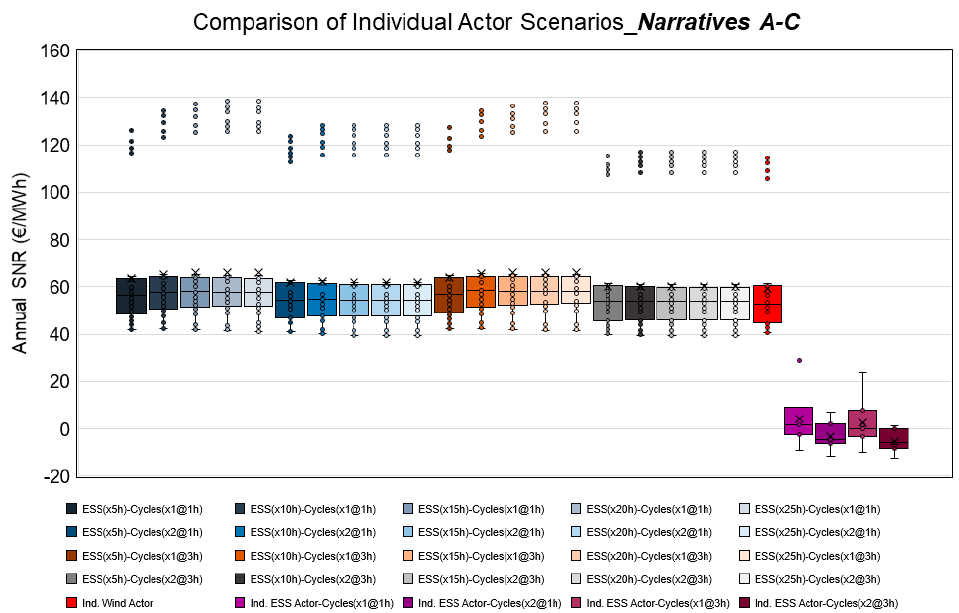
Figure 14. Comparison of independent wind ( a ) and storage ( b ) actors’ annual SNR per different storage configuration and cycling option.